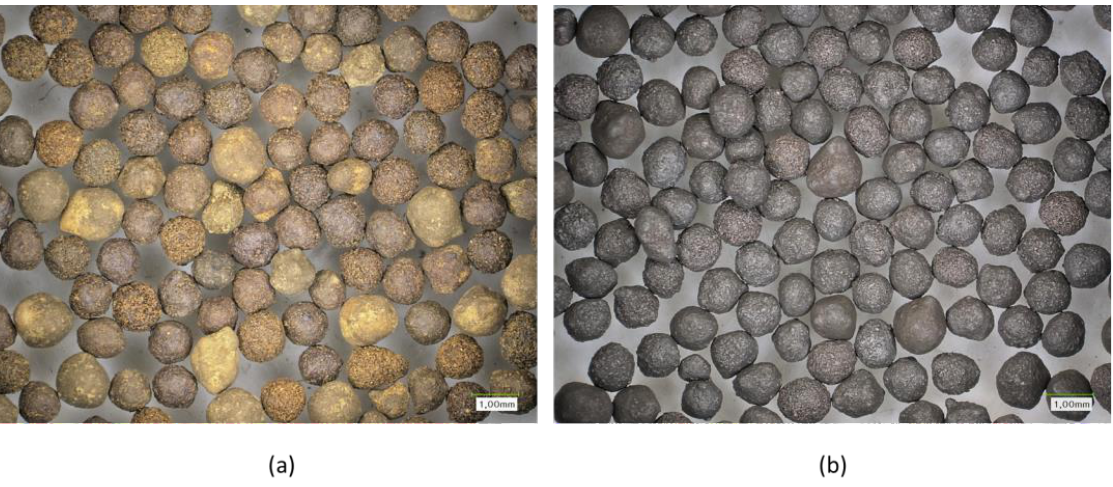
Figure 2. Optical microscope image of BL 1630 bauxite proppants ( a ) before and ( b ) after coating with black spinel-type pigment.